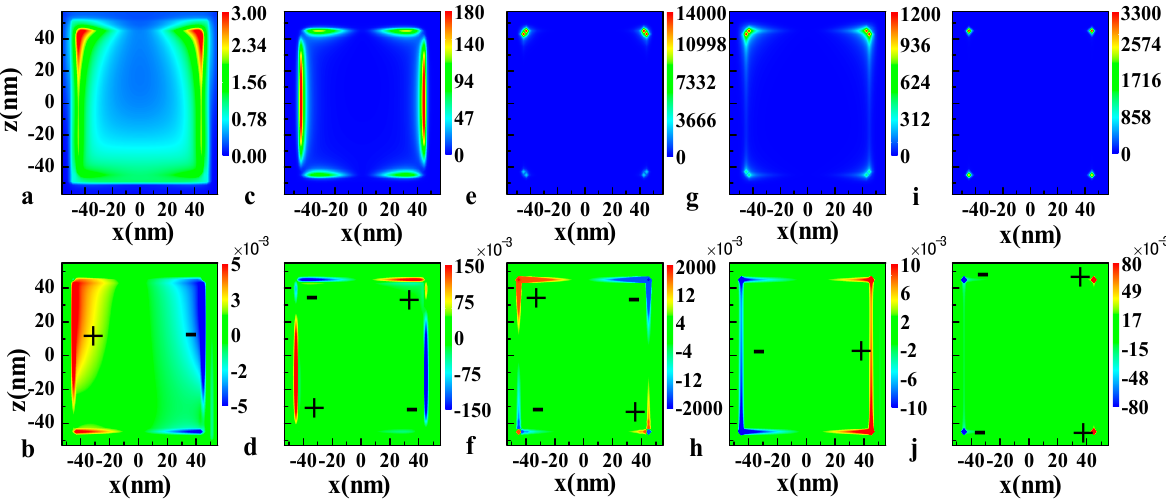
Figure 2. Calculated near-field intensity in the xz plane of a 90 nm silver nanocube at the ( a ) 275 nm, ( c ) 374 nm, ( e ) 447 nm, ( g ) 495 nm and ( i ) 643 nm resonance peaks, respectively. The corresponding polarized electric charge distribution at ( b ) 275 nm, ( d ) 374 nm, ( f ) 447 nm, ( h ) 495 nm and ( j ) 643 nm resonance peaks, respectively. Red and blue colors indicate positive and negative charge, which are also indicated by “+” and “ − ” marks, respectively.